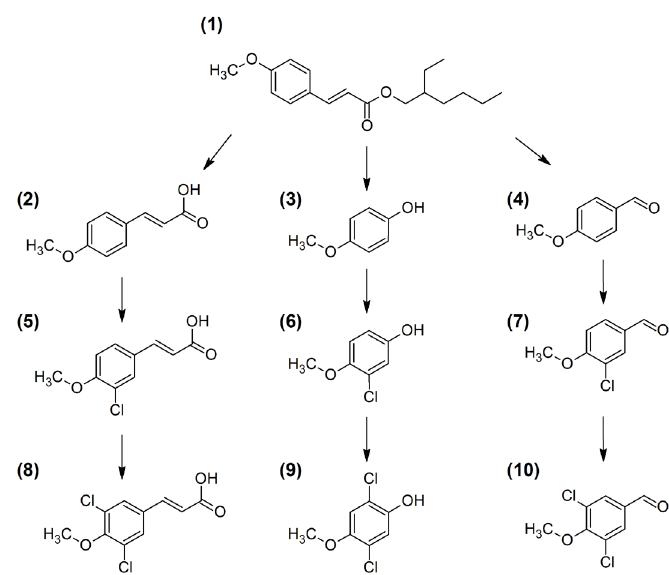
Figure 4. Proposed mechanistic pathways for EHMC photodegradation in presence of H (5) 3-Cl-4-MCA, (6) 3-Cl-4-MP, (7) 3-Cl-4-MBA, (8) 3,5-diCl-4-MCA, (9) 2,5-diCl-4-MP, (10) 3,5-diCl-4-MBA.